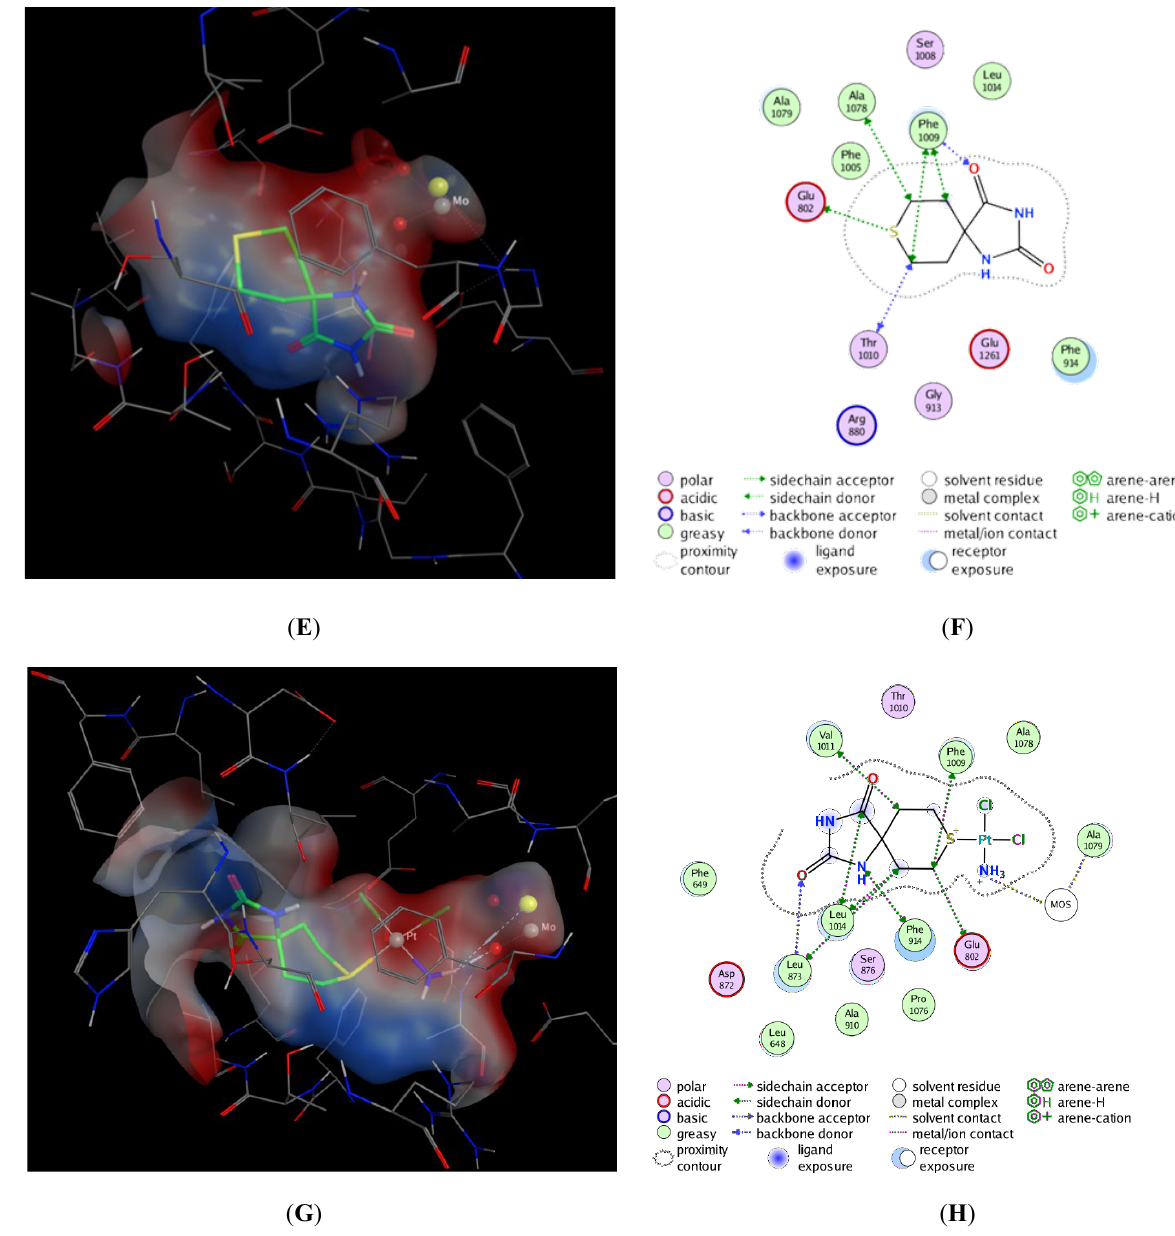
Figure 3. Docking poses and interaction diagrams of ligand ( 1 ) ( A , B ), (complex 2 ) ( C,D ), ligand ( 3 ) ( E , F ) and (complex 4 ) ( G , H ). Visualization of coordinative bonds in the MOE package is denoted as positively charged atoms.